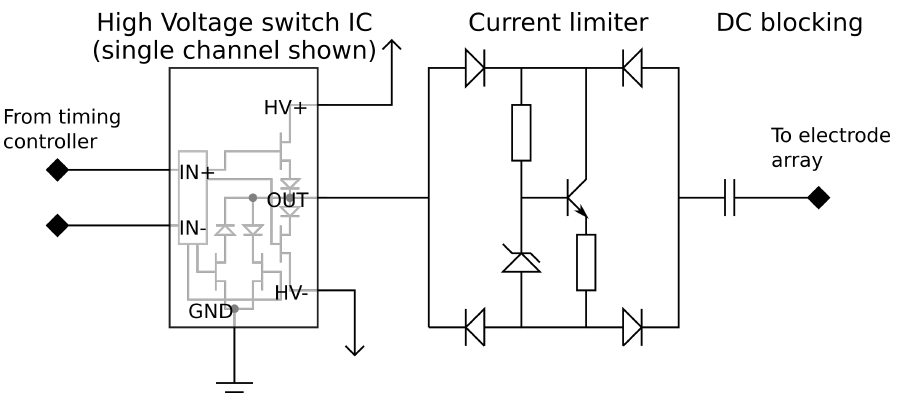
Figure 5. Circuit schematic of stimulation pulse driver board output